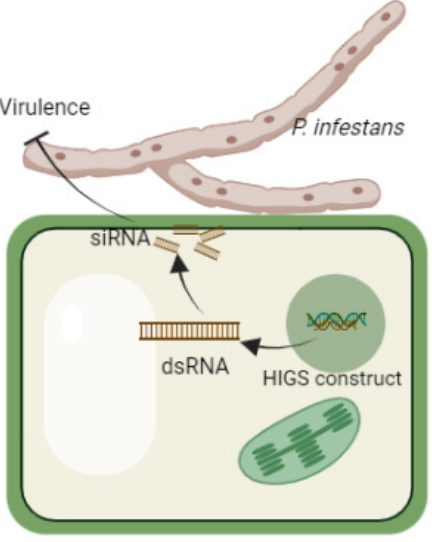
Figure 2. The scheme of HIGS action against P. infestans.